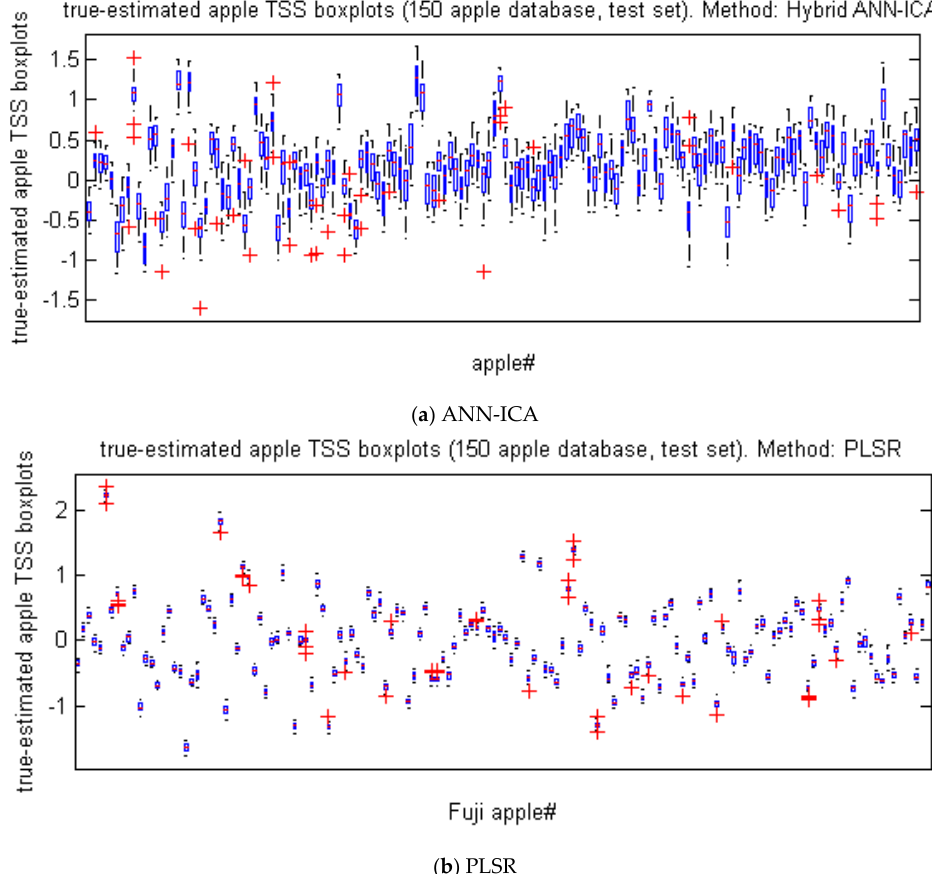
Figure 6 represents the box plot of the difference between the true (measured) and predicted values of TSS in 500 iterations to evaluate the efficiency of ANN-ICA and PLSR for predicting TSS of Gala apples. In fact, more compact box plot diagrams indicate that the predicted values are closer to the true values.